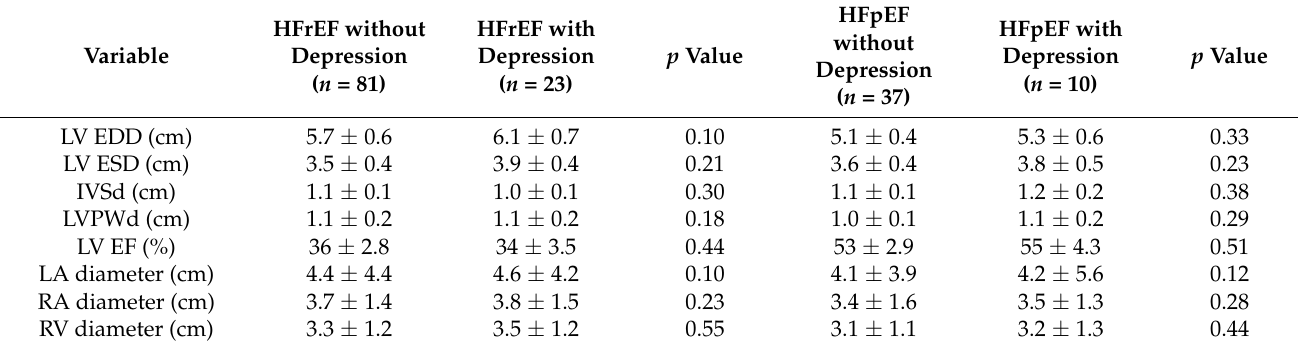
Table 3. Echocardiographic data between HF patients with and without depression according to EF.